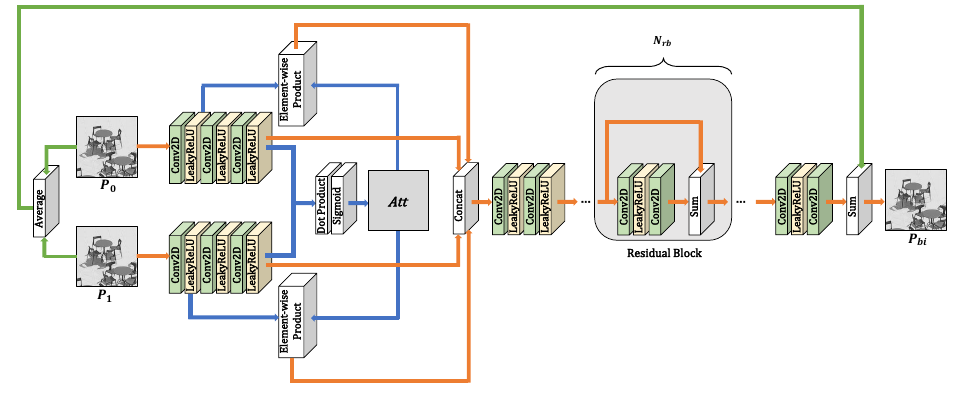
Figure 2. An overview of the proposed